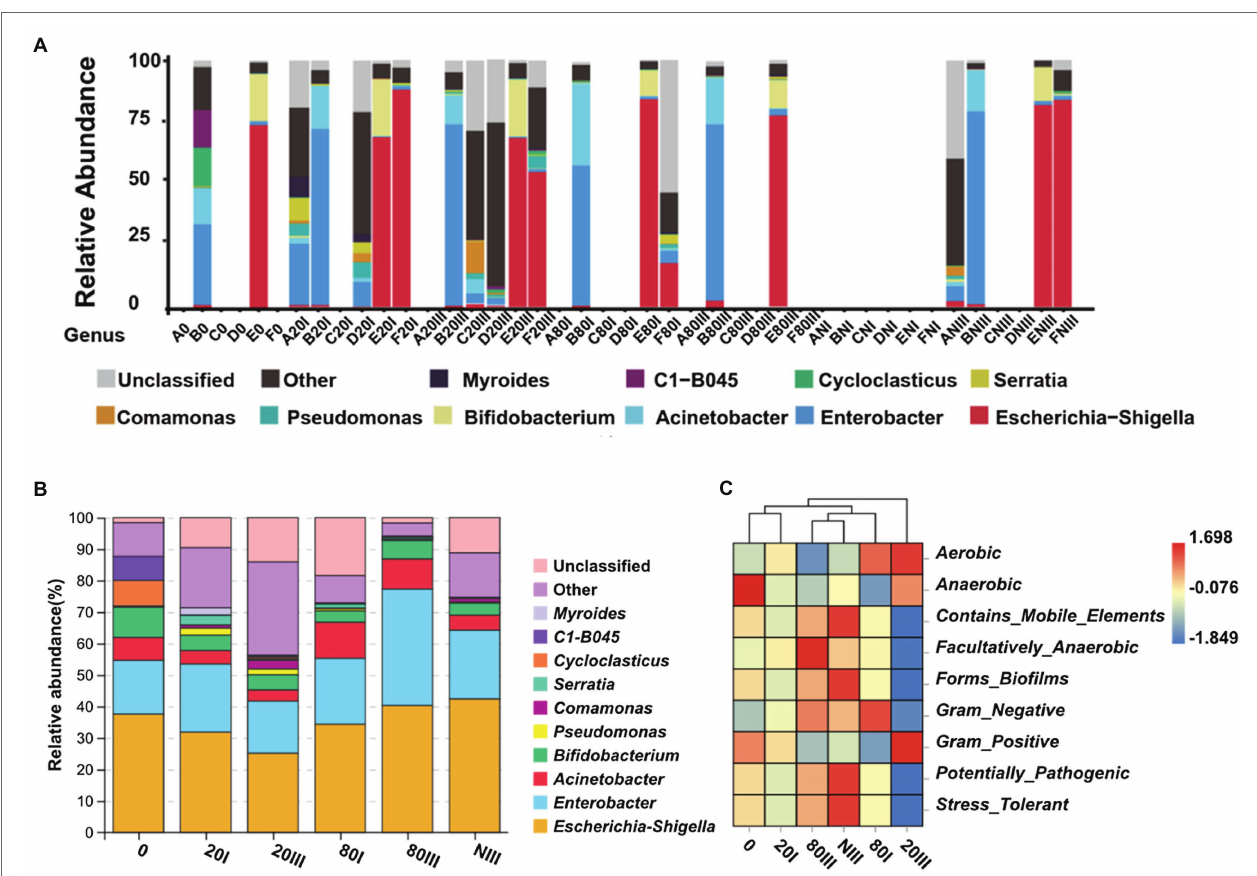
FIGURE 5 | Relative abundance and functional prediction of bacteria at the genus level. (A) The relative abundance of bacterial DNA at the genus level from the perspective of sample. A0–F0: Two (B and E) of six samples could be positively sequenced for bacterial DNA by the reference protocol; A20I–F20I: Five (A, B, D, E, and F) of six samples could be positively sequenced for bacterial DNA with a one-cycle − 20 ° C freeze-thaw protocol; A20III–F20III: Five (B, C, D, E, and F) of six samples could be positively sequenced for bacterial DNA with a three-cycle − 20 ° C freeze-thaw protocol; A80I–F80I: Three (B, E, and F) of six samples could be positively sequenced for bacterial DNA with a one-cycle − 80 ° C freeze-thaw protocol; A80III–F80III: Two (B and E) of six samples could be positively sequenced for bacterial DNA with a three-cycle − 80 ° C freeze-thaw protocol; ANI–FNI: No samples could be positively sequenced for bacterial DNA with a one-cycle liquid nitrogen freeze-thaw protocol; ANIII–FNIII: Four (A, B, E, and F) of six samples could be positively sequenced for bacterial DNA with a three-cycle liquid nitrogen freeze-thaw protocol; (B) The relative abundance of bacterial DNA at the genus level from the perspective of group; (C) Functional prediction of bacterial DNA among five pretreated